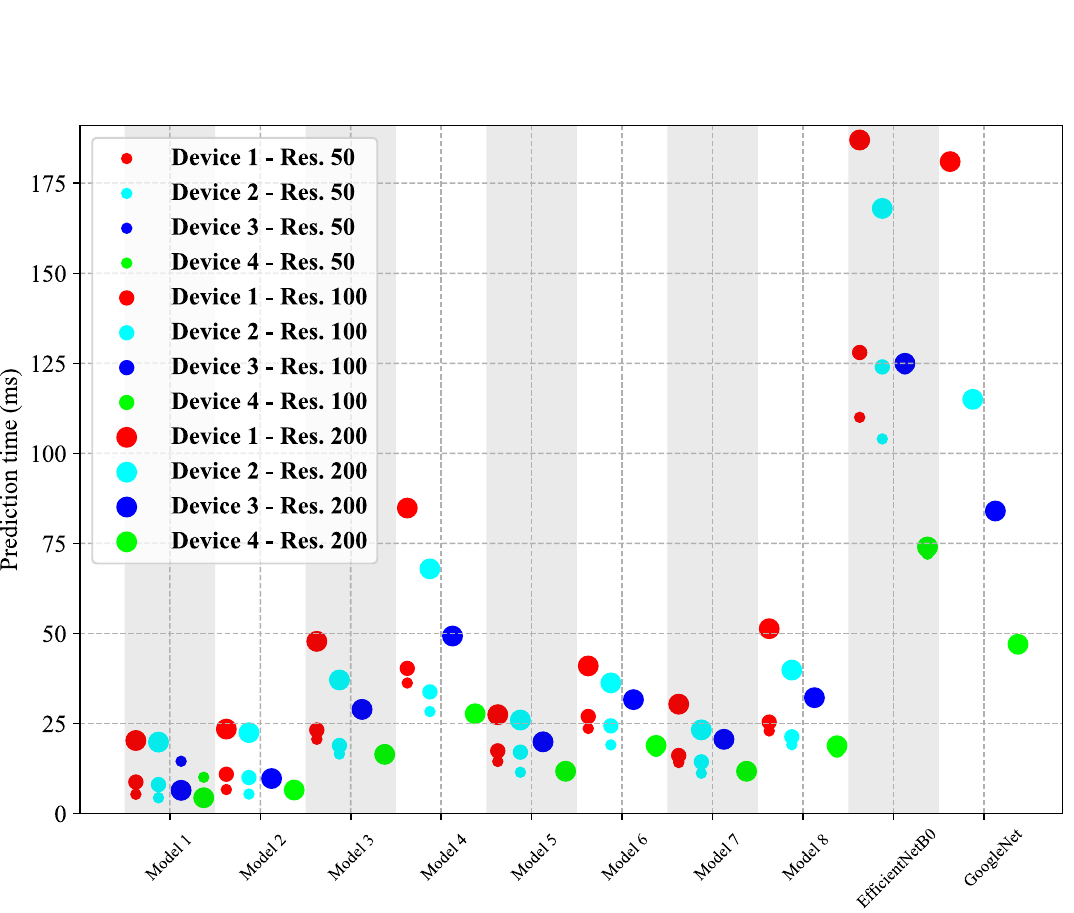
Figure 6. Prediction time of the proposed models with different image input resolution. The code of this paper is available at https:// github. com/ yasam inbor hani/ Plant Disea seCla ssifi